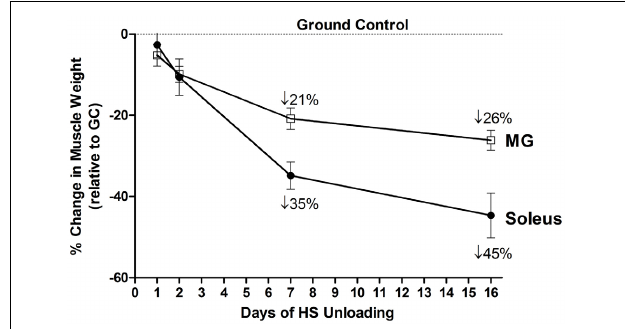
FIGURE 4 | Both soleus and medial gastrocnemius (MG) atrophy in response to unloading. Change in muscle mass relative to control of both MG and Soleus in response to 16 days of hindlimb suspension in